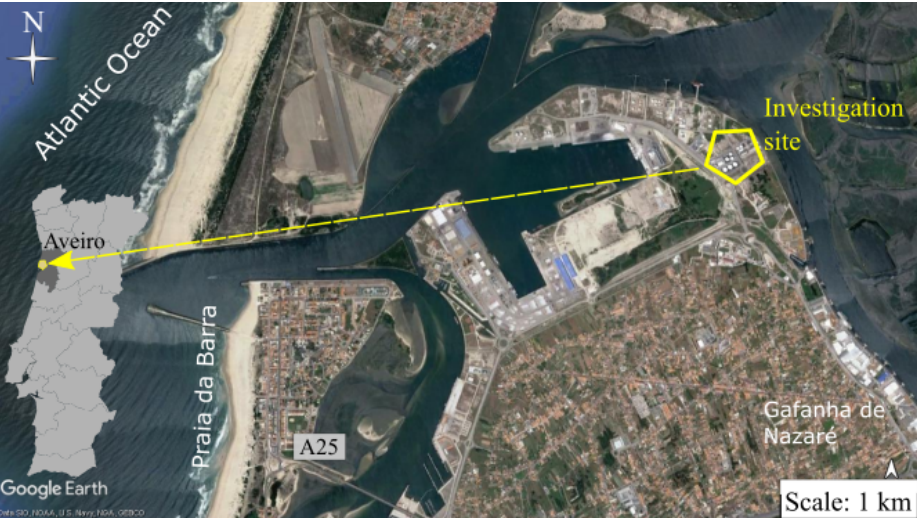
Figure 1. Location of the investigation site (adapted from Google Earth).